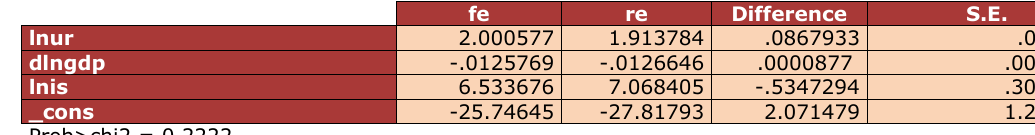
Table 4. Hausman test of panel model of Jiangsu